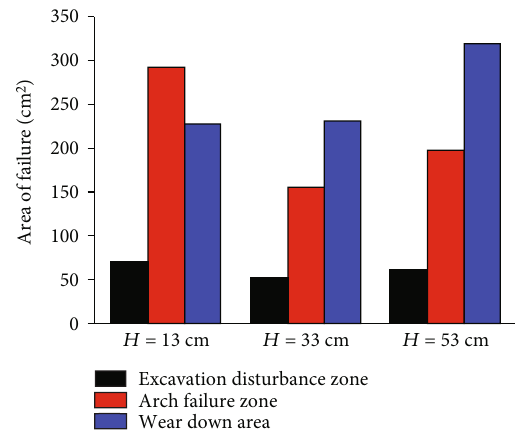
Figure 12: Summary of destruction zones in di ff erent conditions of seepage